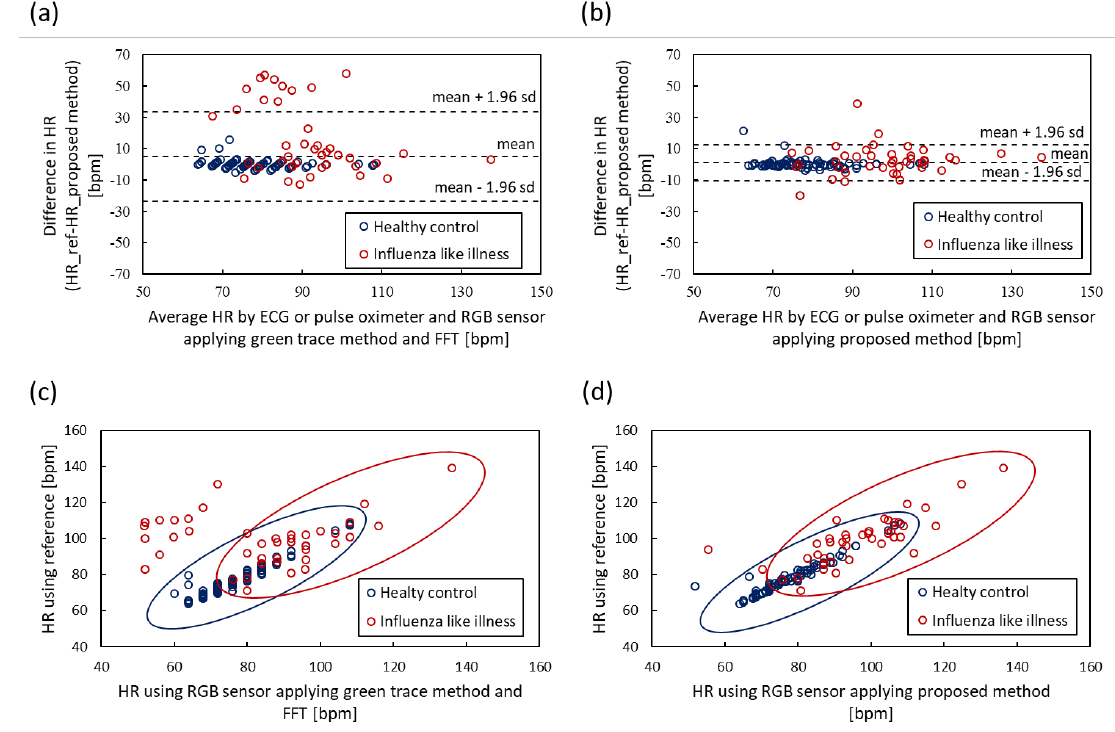
Figure 7. Bland–Altman plots and scatter plots of heart rate (HR) obtained by RGB sensor and electrocardiogram (ECG) or pulse oximeter. ( a ) Bland–Altman plot of raw green trace method applying FFT. ( b ) Bland–Altman plot of the proposed method applying tapered window, signal reconstruction and MUSIC. ( c ) Scatter plot of raw green trace. ( d ) Scatter plot of proposed method.